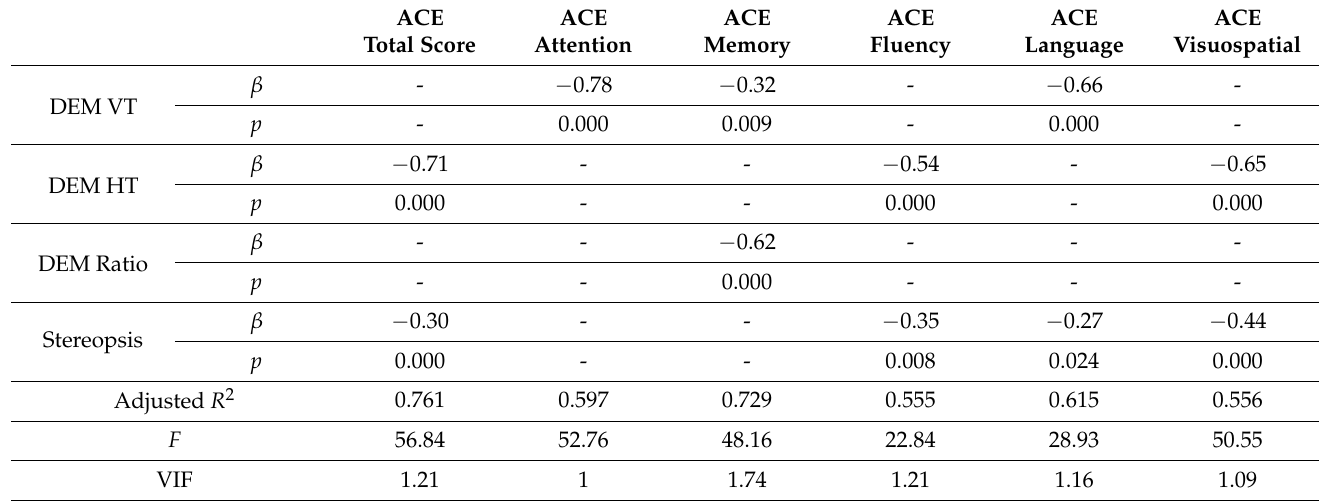
Table 2. Linear regression analysis (forward) of visual function and cognitive